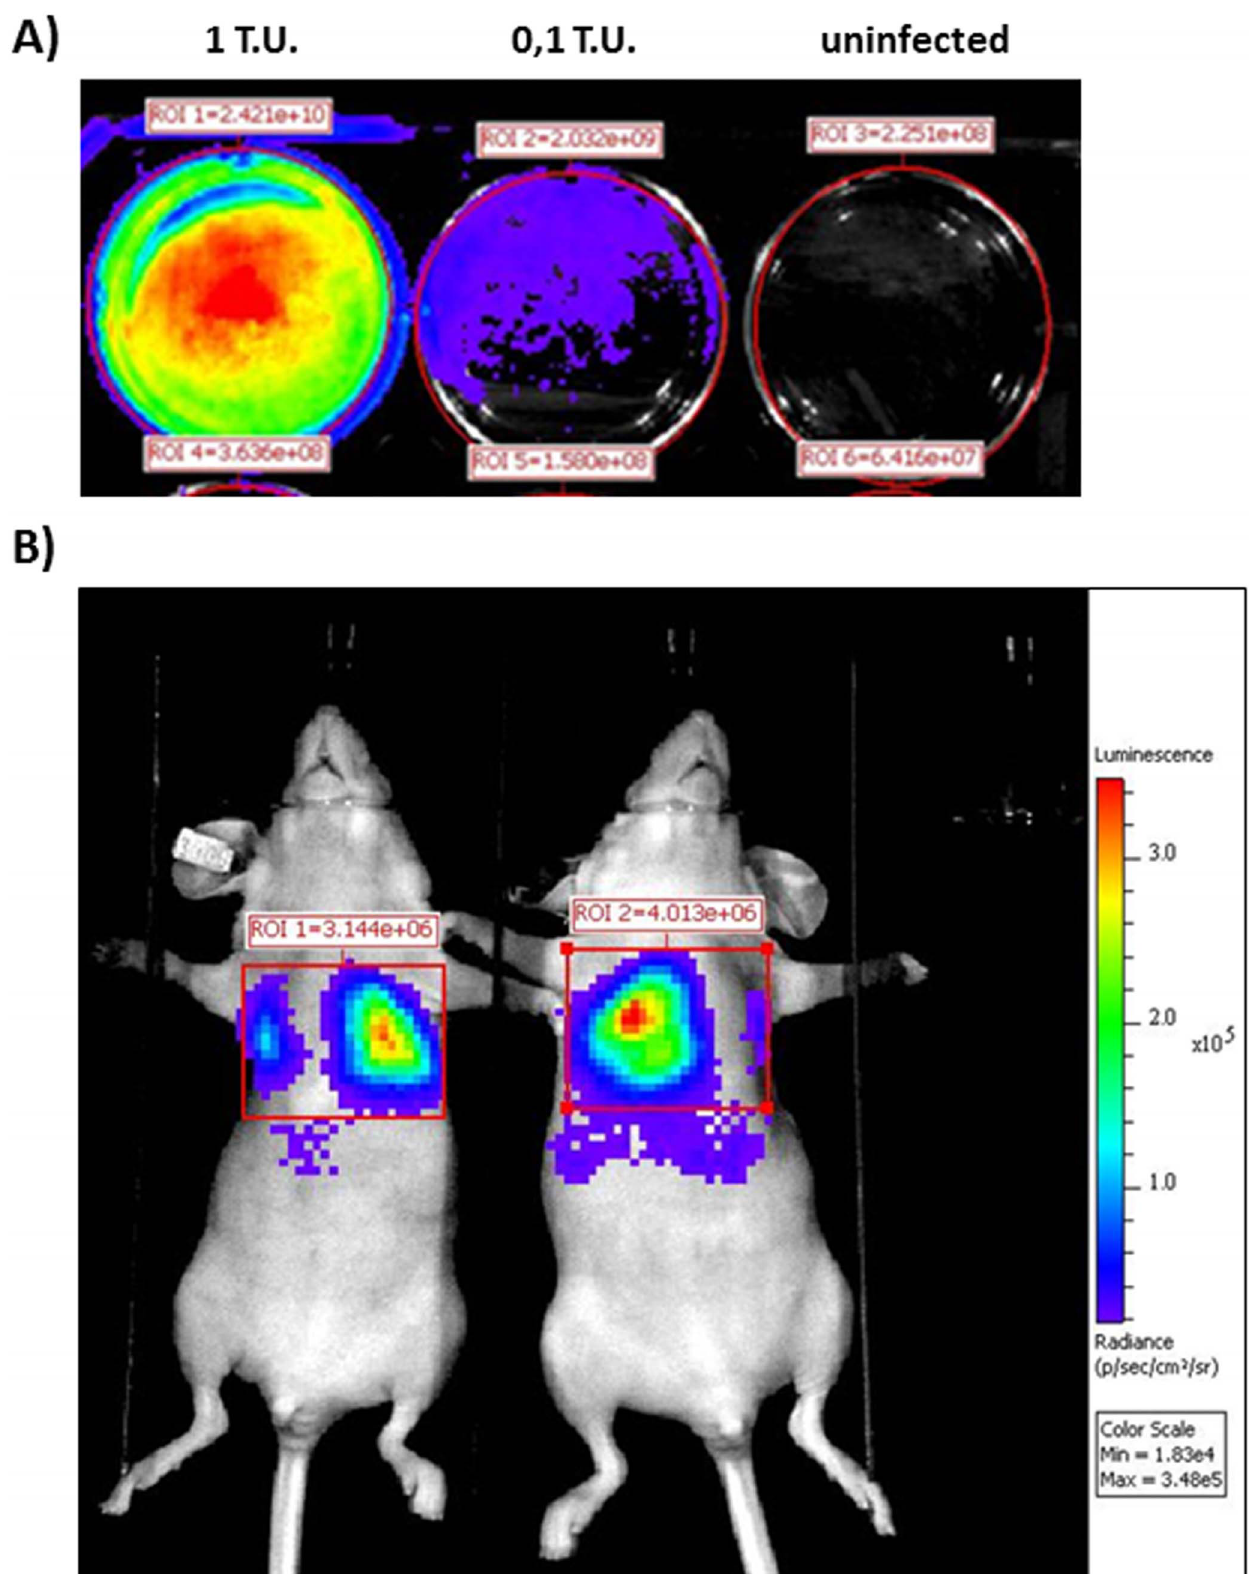
Figure 7. ASSC biodistribution. A) Representative in vivo bioluminescence image of ASSCs transduced with different doses (1 and 0.1 transducing units (T.U.)/cell) of a lentiviral vector expressing luciferase. B) Representative in vivo bioluminescence image of FVB mice displaying ASSCs transduced with a lentiviral vector expressing luciferase and localized to the lung 4 h post injection.